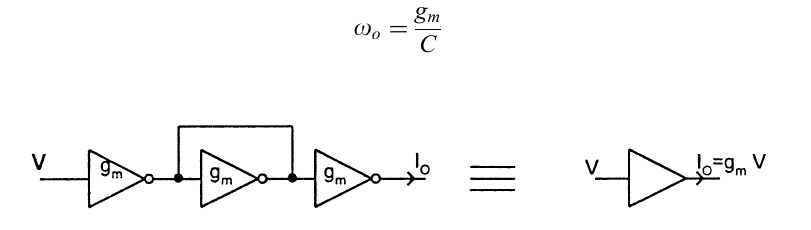
FIGURE 2 Non-inverting transconductance